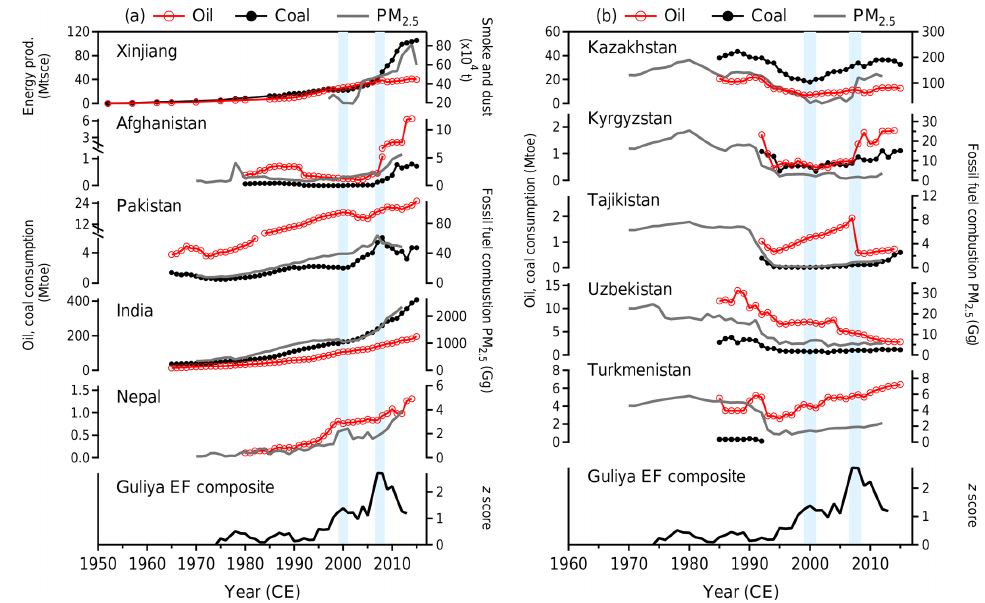
Figure 4. Oil and coal consumption in (a) Xinjiang, as coal energy production in million tonnes of standard coal equivalent (Jianxin, 2016), Afghanistan, in million tonnes of oil equivalent (Mtoe; EIA, 2019), Pakistan (BP, 2019), India (BP, 2019), and Nepal (coal ≤ 0 . 1Mtoe; EIA, 2019). (b) Central Asian countries: Kazakhstan (BP, 2019), Kyrgyzstan and Tajikistan (EIA, 2019), and Uzbekistan and Turkmenistan (BP, 2019). PM 2 . 5 emissions from fossil fuel combustion sources (EDGARv4.3.2, 2017; Crippa et al., 2018), shown in both panels for all countries except Xinjiang (China). Smoke and dust emissions from Xinjiang (Ning, 2019) are shown, since no PM 2 . 5 data were available. The Guliya EF composite (average of Cd, Pb, Zn, and Ni EF z scores) is shown at the bottom of each panel for comparison. The two Guliya maxima at 2000 and 2008 are shown as shaded